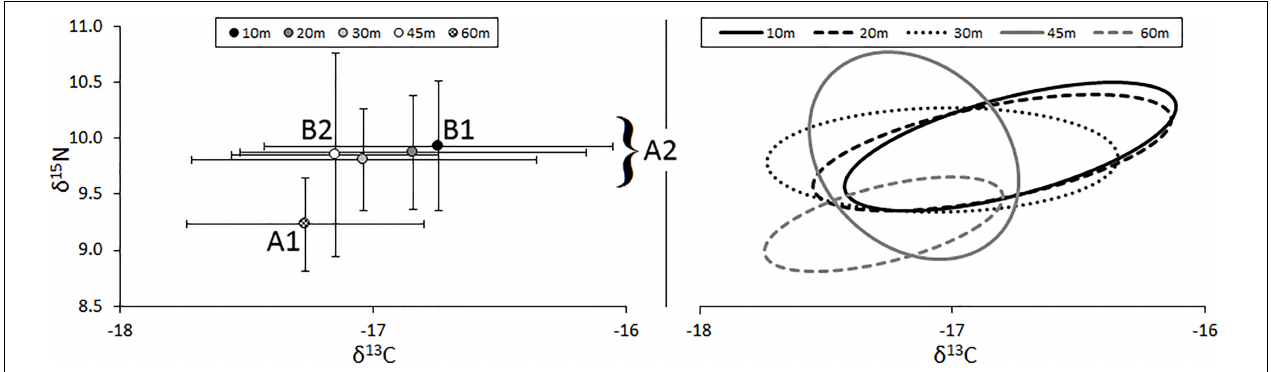
FIGURE 3 | (Left) Mean ( ± SE) isotope values and (right) isotopic niches (SEA c ) for lionfish captured at different depths. Sample sizes for 10-, 20-, 30-, 45-, and 60-m groups are 43, 18, 36, 30, and 55, respectively. Niche position was significantly different between lionfish captured at 60 m (A1) and all other depths (A2; Hotelling’s T 2 test; p < 0.05) and between those captured at 10 m (B1) and 45 m (B2; Hotelling’s T 2 test; p < 0.05).